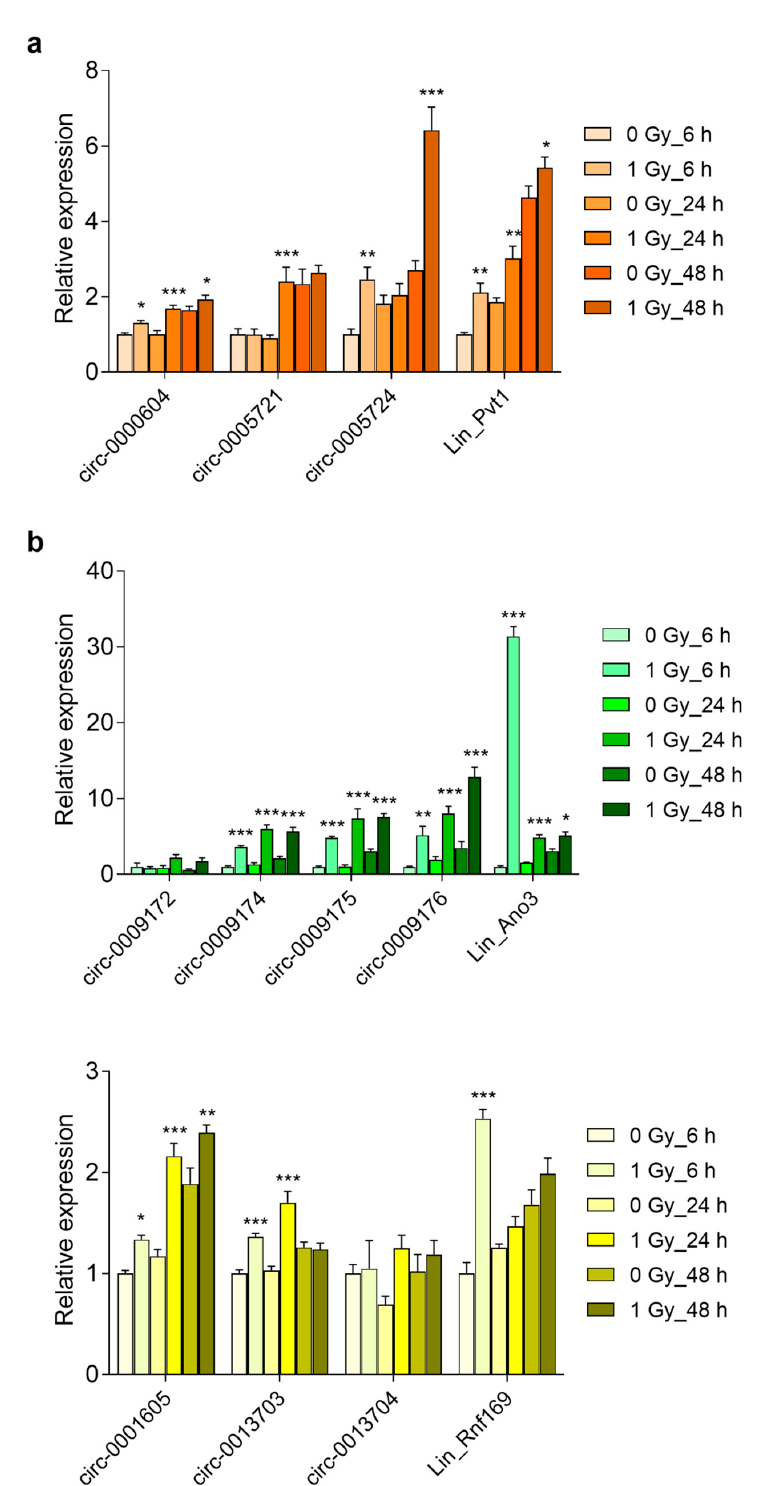
Figure 8. Radiation-induced RNA abundance in primary cortical neurons. Relative levels of linear and circular ( a ) Pvt1; ( b ); Ano3; ( c ) Sec14l5; and, ( d ) Rnf169 were determined by RT-qPCR at 6 h, 24 h, and 48 h after irradiation of DIV1 primary cortical neurons. Data shown are means + s.e.m. of three biological replicates ( n = 3) and have been normalized against 0 Gy_6 h. Statistics were performed while using two-way ANOVA with correction for multiple comparisons using the two-stage step-up method of Benjamini, Krieger, and Yekutieli; * p < 0.05; ** p < 0.01; *** p <